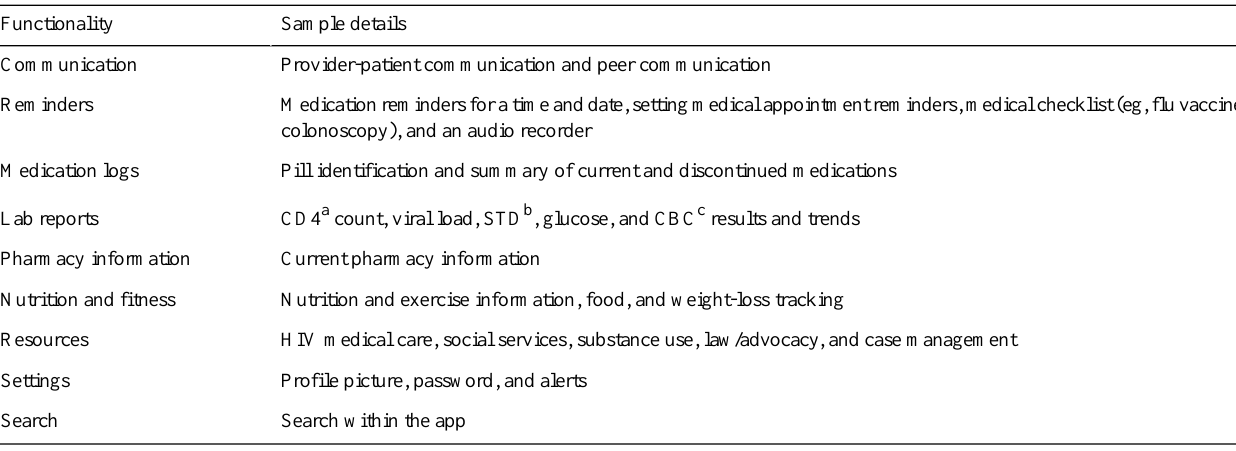
Table 1. User-centered design self-management app for persons living with HIV: functionalities and sample details. Sample